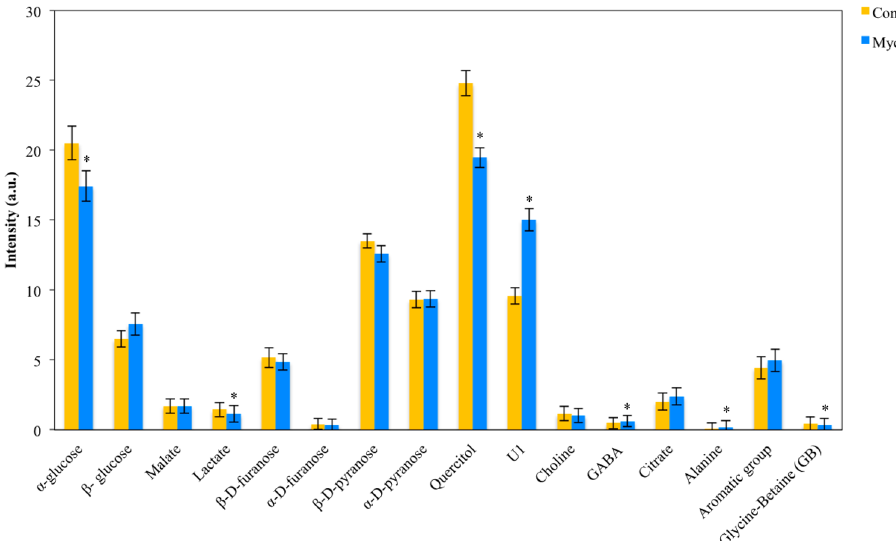
Figure 3. Comparisons between mycorrhizal (Myc) and non-inoculated (Cont) peak areas of root metabolites identified by NMR analysis. *Indicates statistical differences at the level P < 0.05